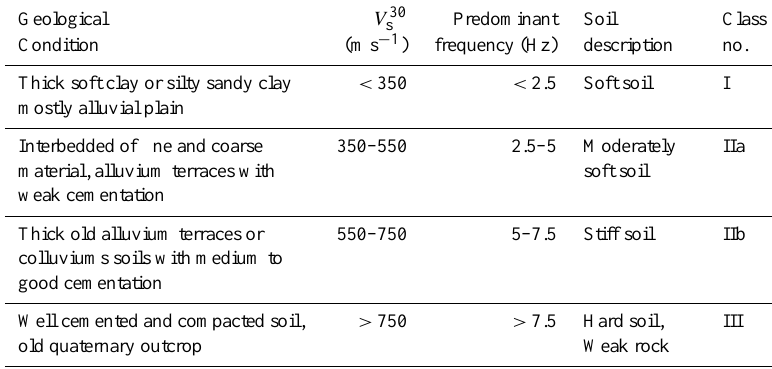
Table 1. Site effect classification of Komak Panah et al. (2002).